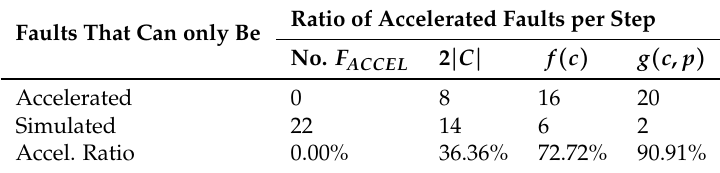
Table 1. Results at each step of the M-AC/DC analysis.